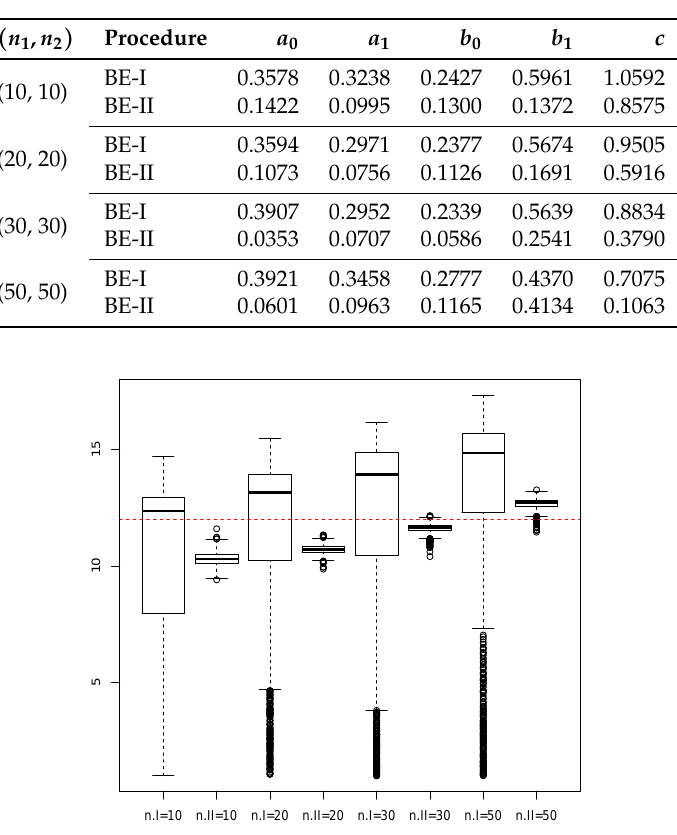
Table 2. The relative square root of mean square errors (RsqMSEs) of Bayes estimates for n 1 = n 2 = 10, 20, 30, and 50.